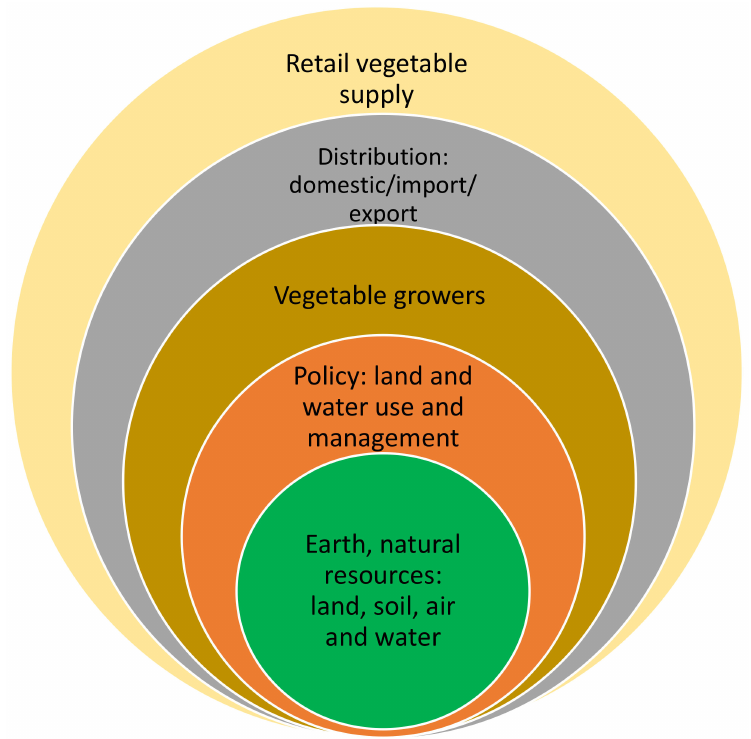
Figure 1. System outcome frameworkapplied to the relationships between the earth, land, soil and water use, and the retail supply of vegetables to the